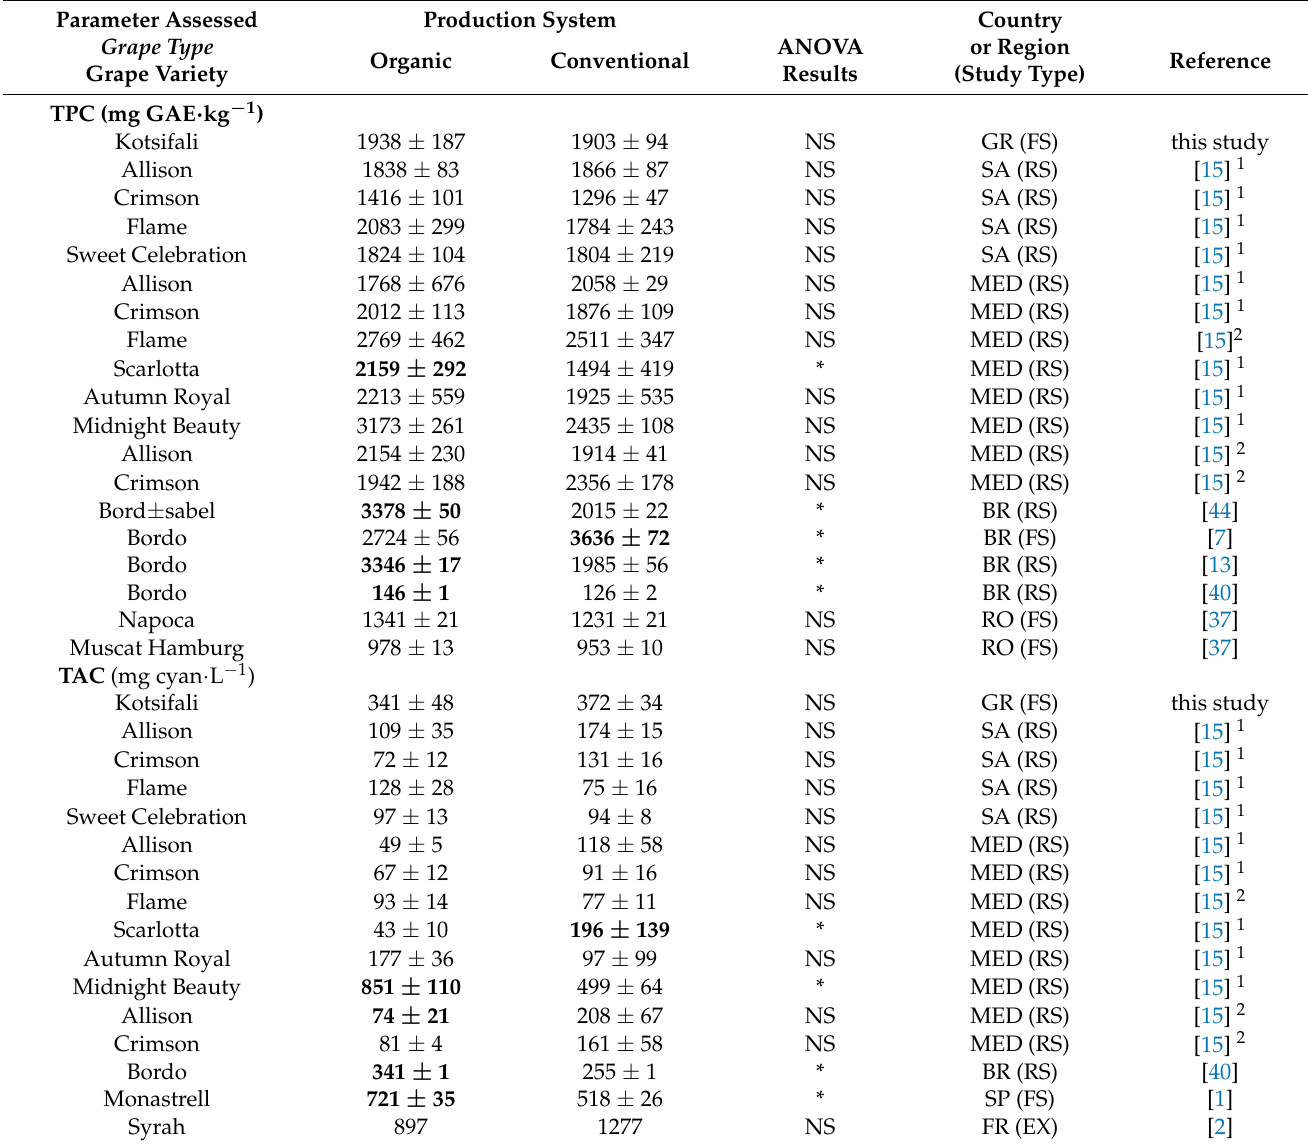
Table 5. Total phenolic content (TPC) and total anthocyanin content (TAC) reported for different red/black grape varieties grown in organic and conventional production systems in different